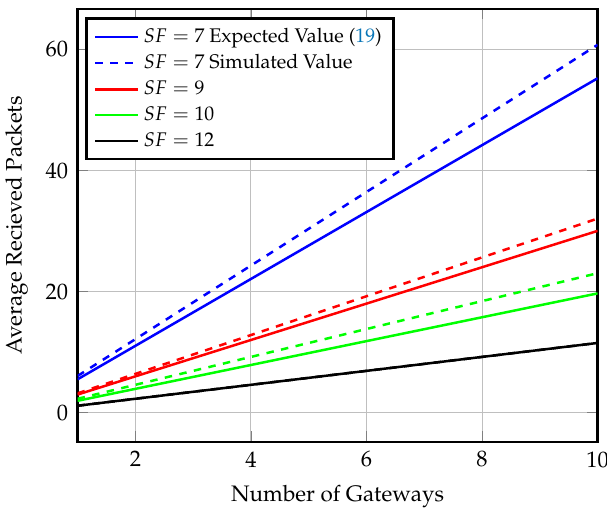
Figure 15. Average number of received packets for different SF values and multiple gateways at speed = 80 km/h and R on = 8 windows/h for nonsynchronized gateway arrival scenario.